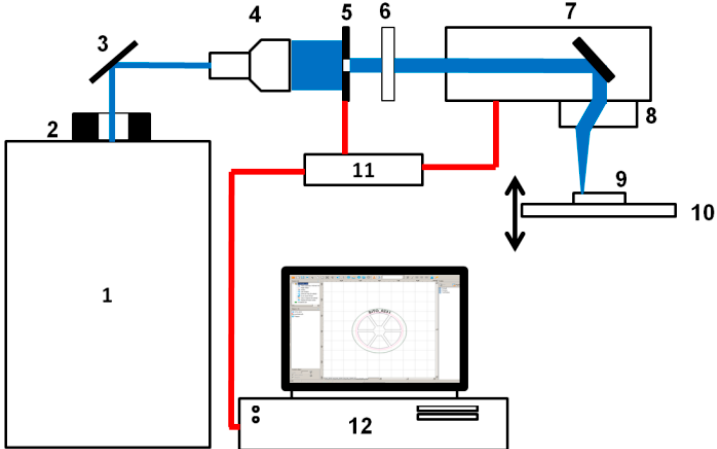
Figure 1. Diagram of a laser system used, which was composed of 1—PL2210 / SH / TH / FH picosecond laser (produced by EKSPLA); 2—Thorlabs shutter (Optical Beam Shutter SH05); 3—plane mirror; 4—laser beam polarizing damper; 5—Thorlabs BE05-355 optical beam expander with quintuple magnification; 6—iris diaphragm ϕ 5.8 mm; 7—SS-IIE10 355 nm galvanometric scanner produced by